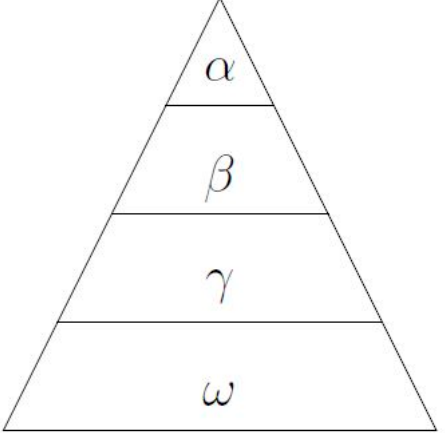
Figure 6. Hierarchy of grey wolves.